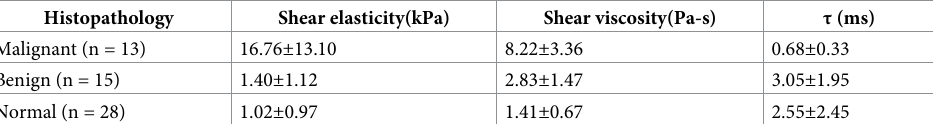
Table 1. Mean and standard deviation values of Voigt-based viscoelastic parameters for malignant, benign and normal breast tissue.